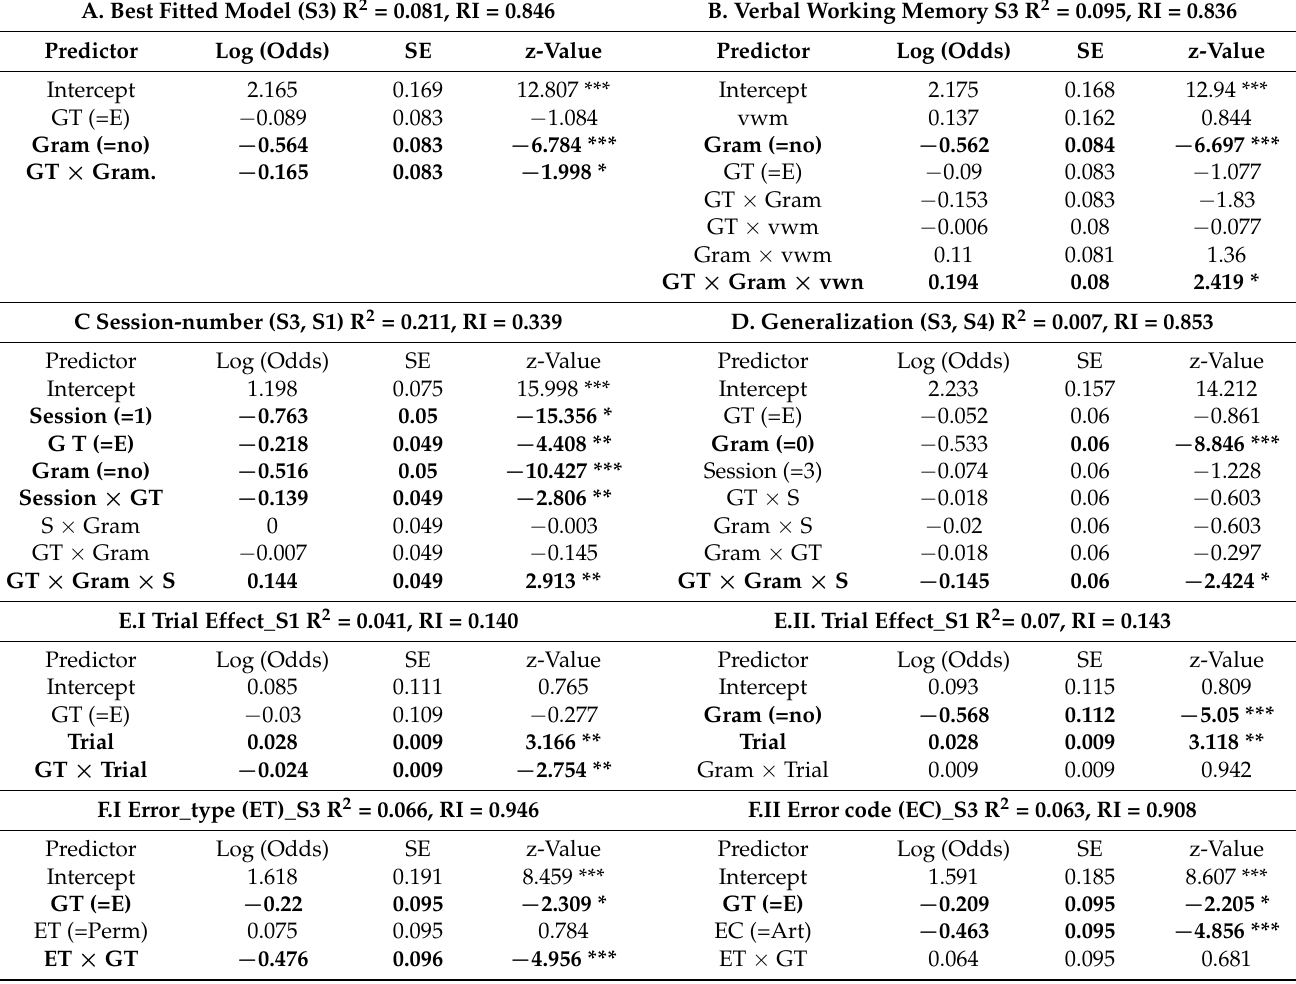
Table 2. HP results. Fixed effects and their interactions for all relevant statistical